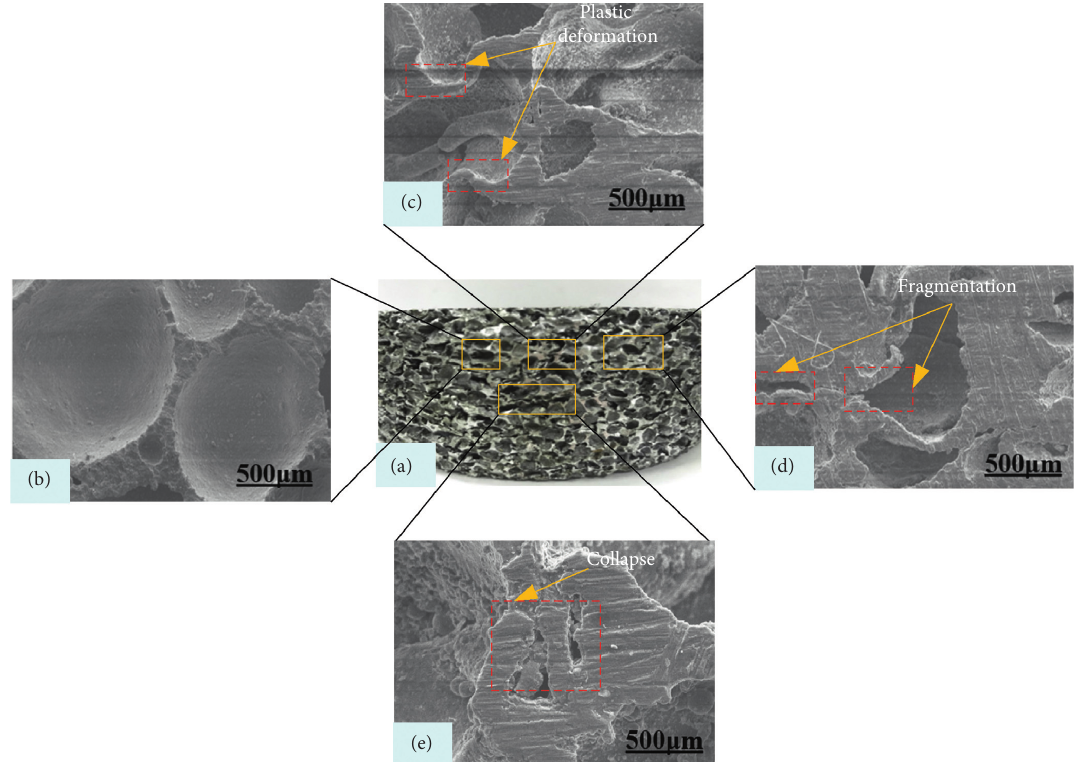
Figure 17: Wave elimination rate curve of aluminum foam under different porosity.